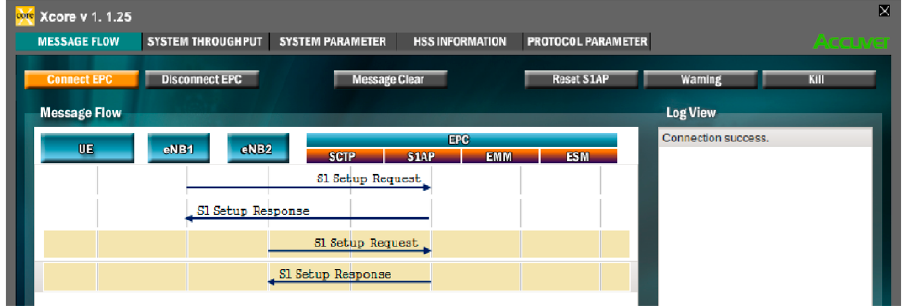
Figure 7. Message flow interface between eNB and EPC.